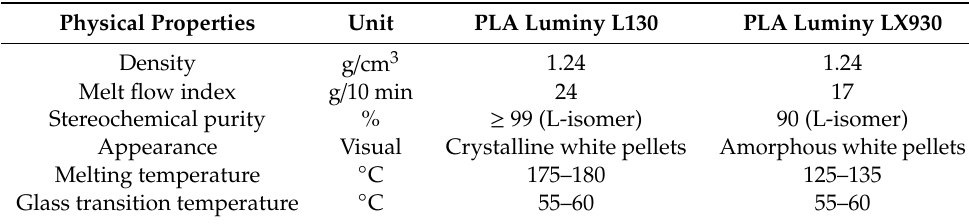
Table 1. Physical properties of Polylactic acid (PLA) pellets.